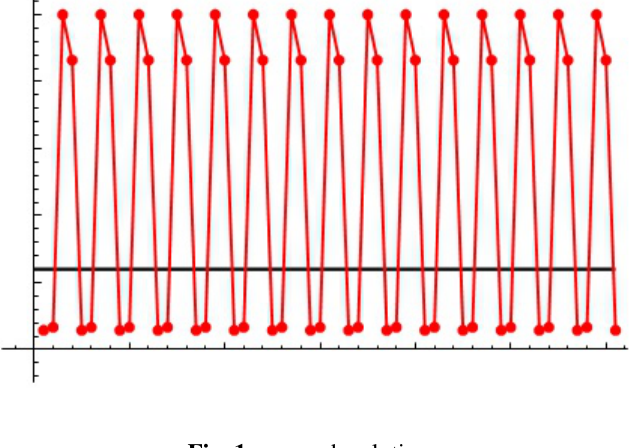
Fig. 1 x n graph solution.